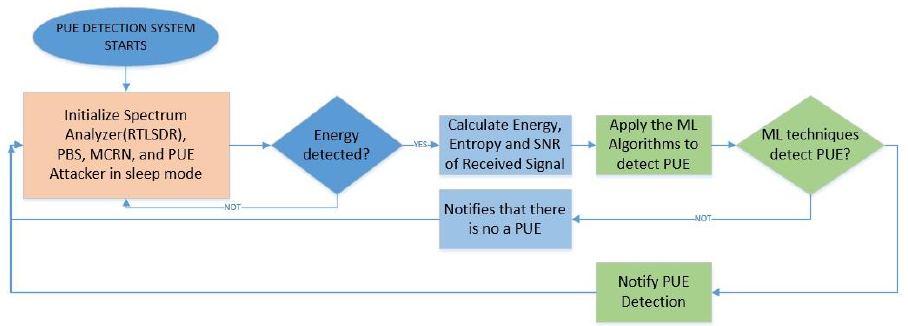
Figure 9. PUE detection system flowchart.